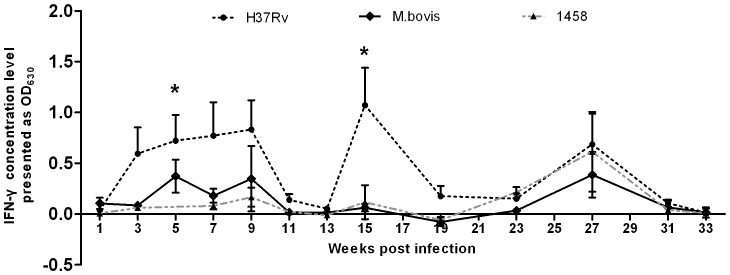
Experimental infection of calves with M. tbH37Rv, M.tb1458 of bovine origin and M. bovis induced IFN-γ production after in vitro stimulation with bovine PPD.The IFN-γ concentrations, which were measured by BOVIGAM® ELISA kit and expressed as OD630 values, fluctuated with the time course of infection. The OD630 values at each timepoint were presented as mean ± SEM. On week 7PI, there were significant differences between the M. tbH37Rv- and M. tb1458-infected groups, while at week 15 PI, the difference were statistically significant between the M. tbH37Rv vs.1458, and M. tbH37Rv vs. M. bovis infected groups.